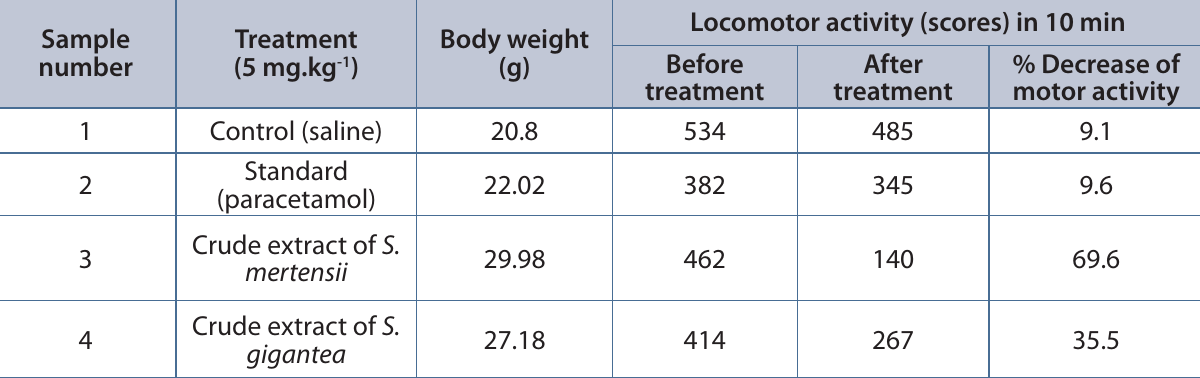
Table 2. Central nervous system activity (CNS) of S. mertensii and S. gigantea extract at 2 mg.kg –1 of 20 ± 2 g male albino mice